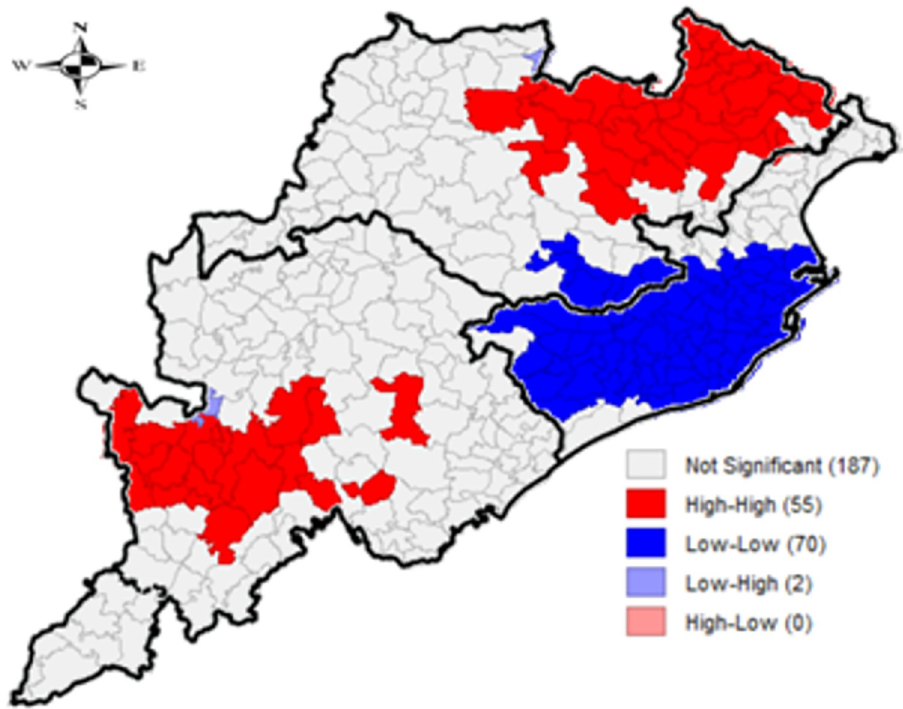
Fig 2. Univariate LISA cluster map for children underweight, block-wise, CCM-II, 2014–15, Odisha, India.